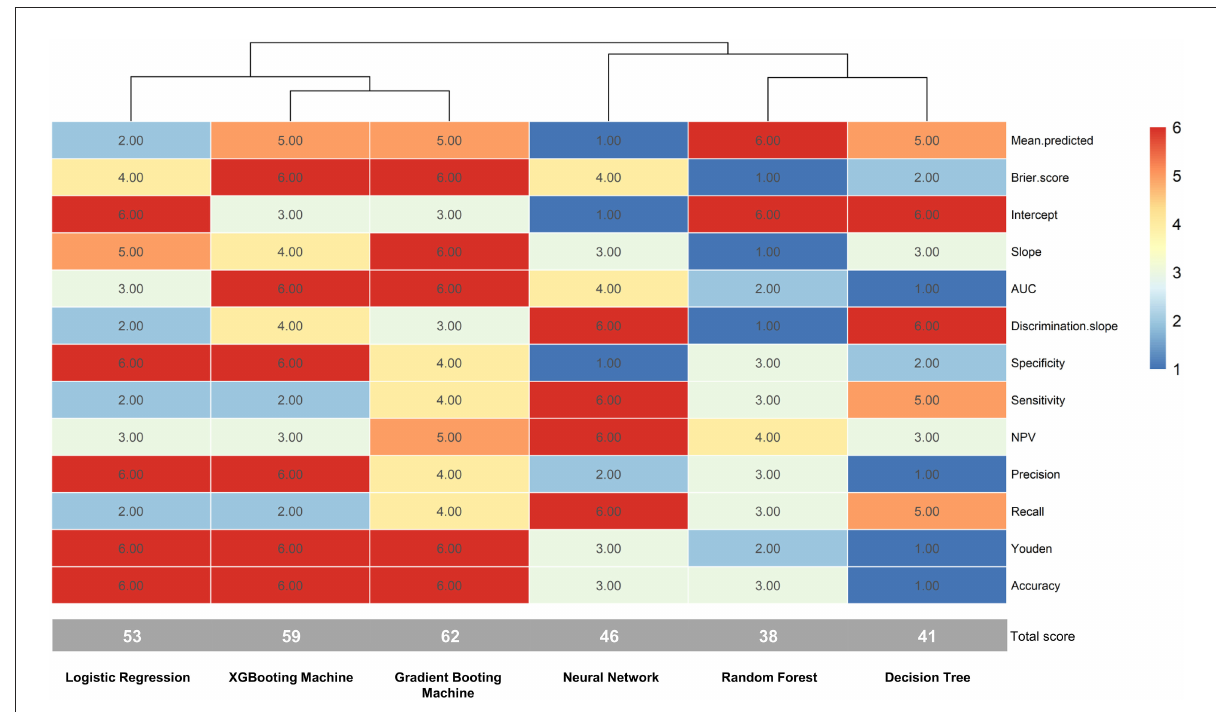
FIGURE4 The heatmap of prediction metrics for the six techniques. AUC, area under curve; NPV, negative predictive